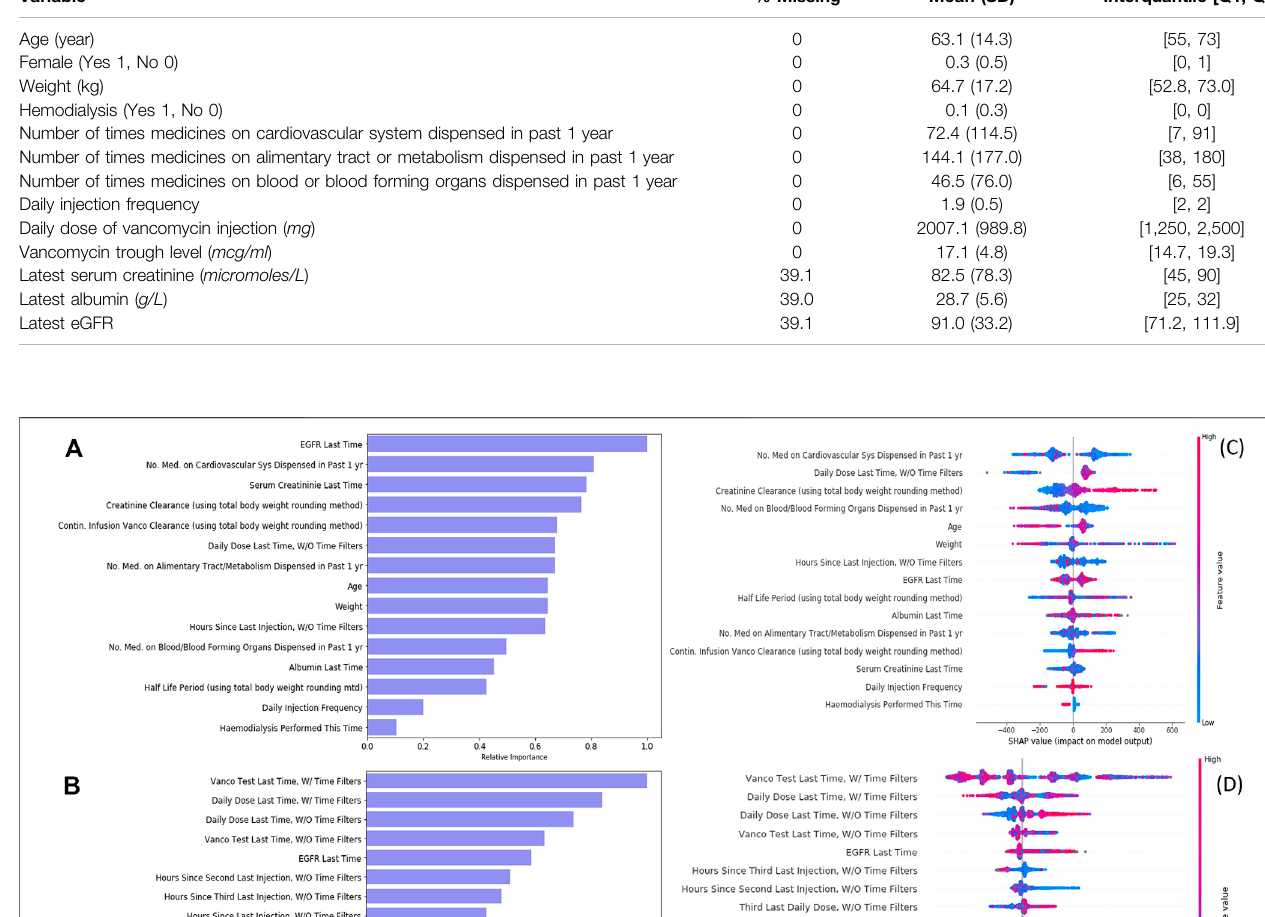
cardiovascular system. In Table 3 , the number of times medicines